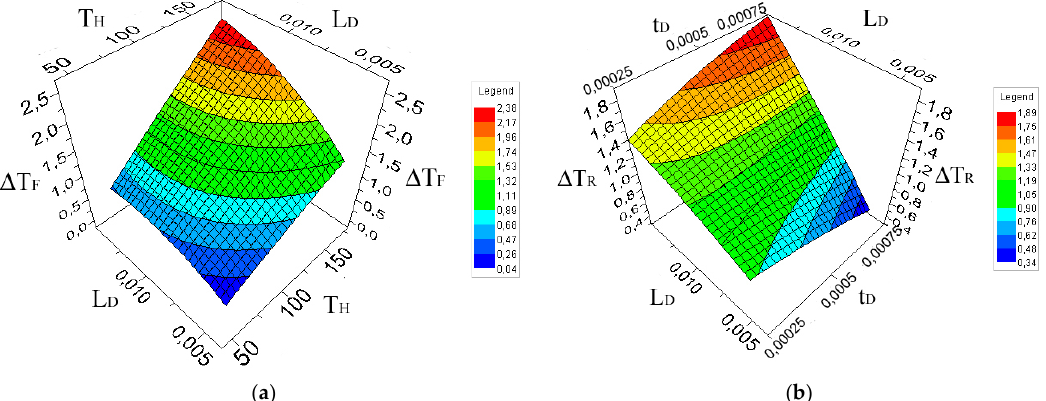
Figure 6. Approximation surfaces for different input and output variables combinations. ( a ) “Contrast Front”; ( b ) “ContrastRear”.